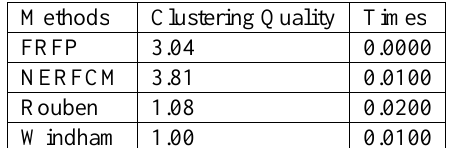
Table 9 Clustering and cluster quality measures